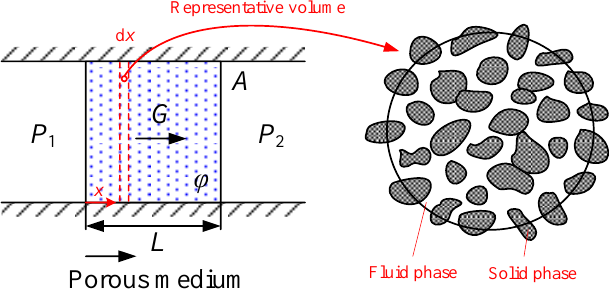
Figure 1. Schematic diagram of airflow through a porous medium.